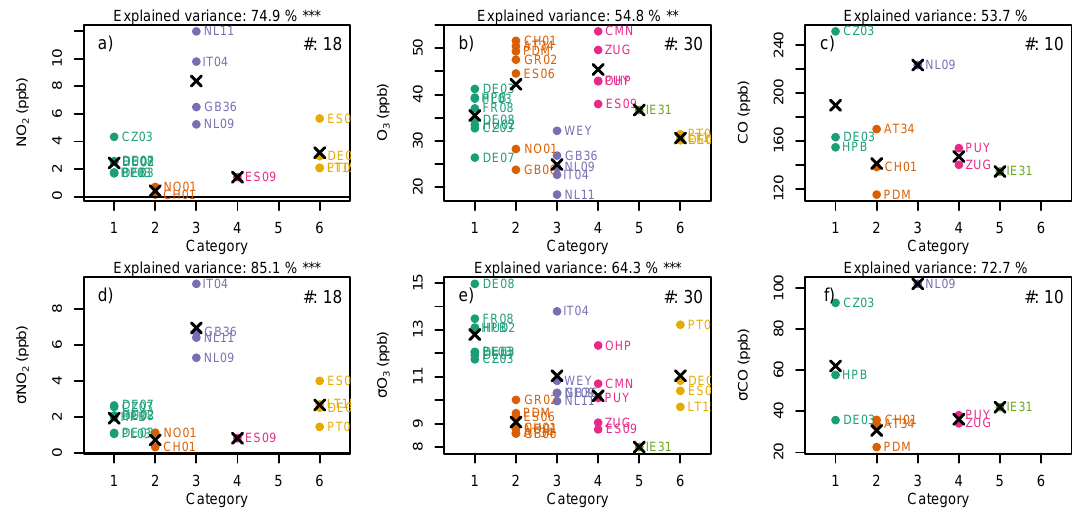
Fig. 5. Sites’ median (upper row) and standard deviation (lower row) of observed daily mean mixing ratios of (a, d) NO 2 , (b, e) O 3 , (c, f) CO by site plotted versus site category. Black crosses represent the category mean. The star notation in each panel represents the confidence level of differences between category means as derived from ANOVA f statistics ( ∗ : α< 0 . 1, ∗∗ : α< 0 . 05, ∗∗∗ : α< 0 .